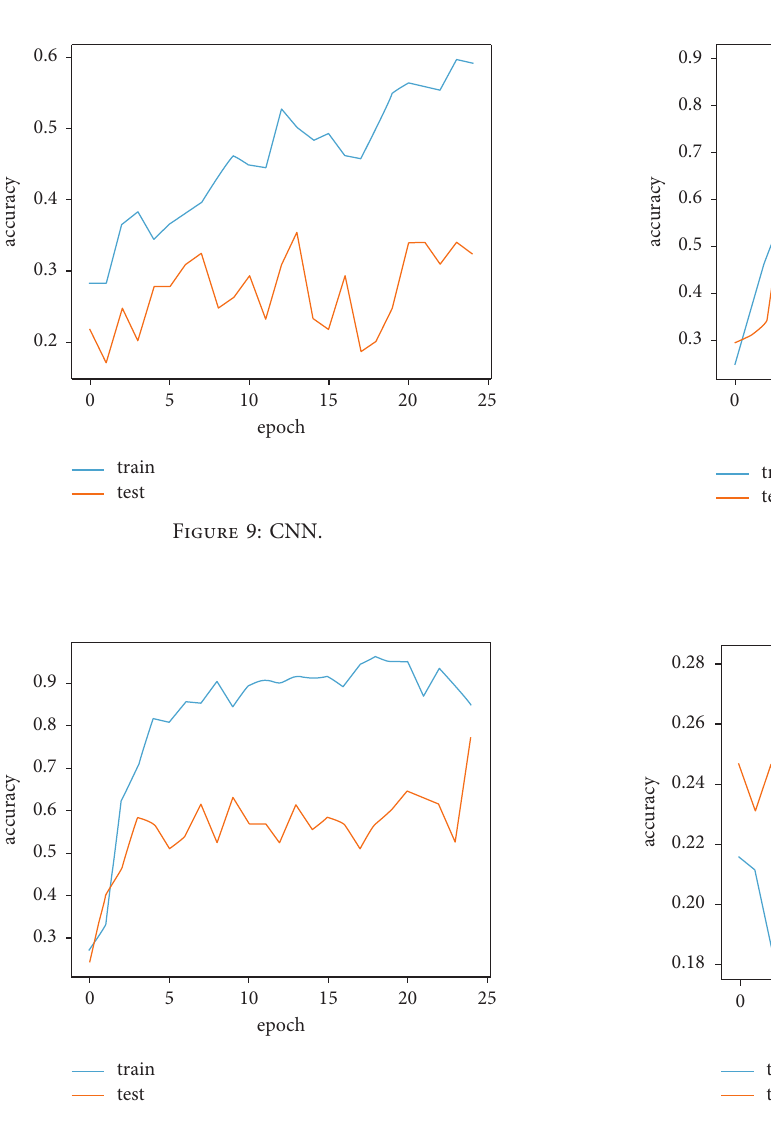
Figure 10: DenseNet-121.